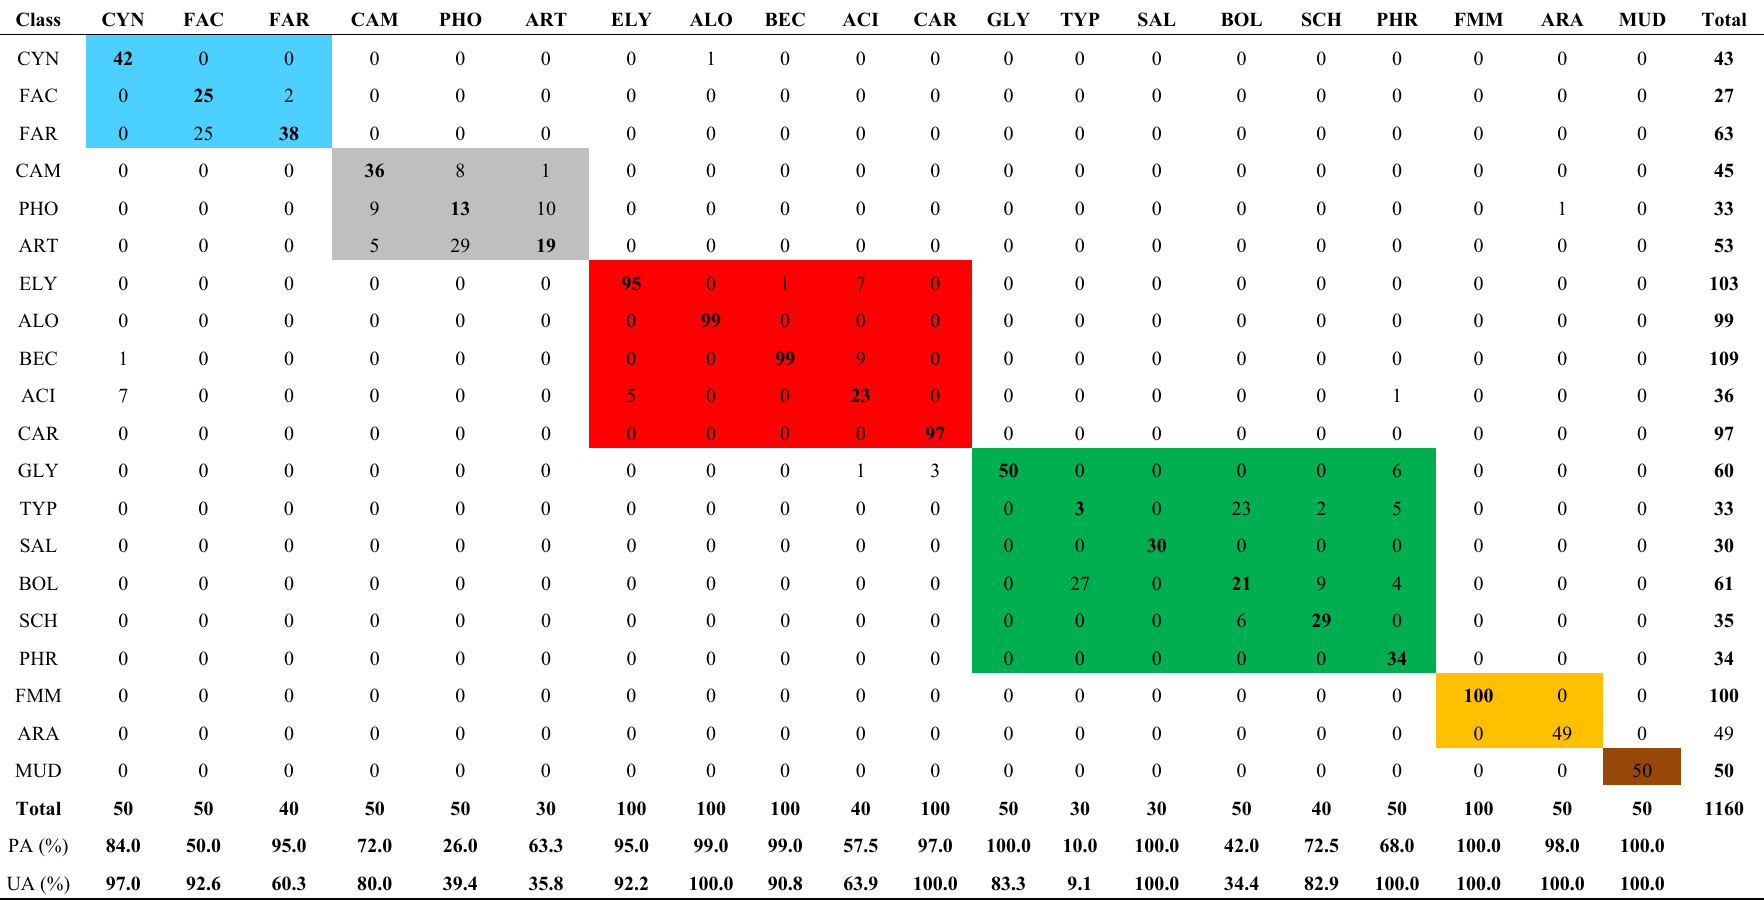
Table 4. Confusion matrix of SVM classification using 9 MNF-transformed bands with 30 training pixels. Identical groups are represented by the same color (cyan—dry steppic grasslands; gray—open alkali grasslands; red—meadow and sedge vegetation; green—marshes; orange—sparsely vegetated areas; brown—muddy surface). Notations: UA: User’s Accuracy; PA: Producer’s